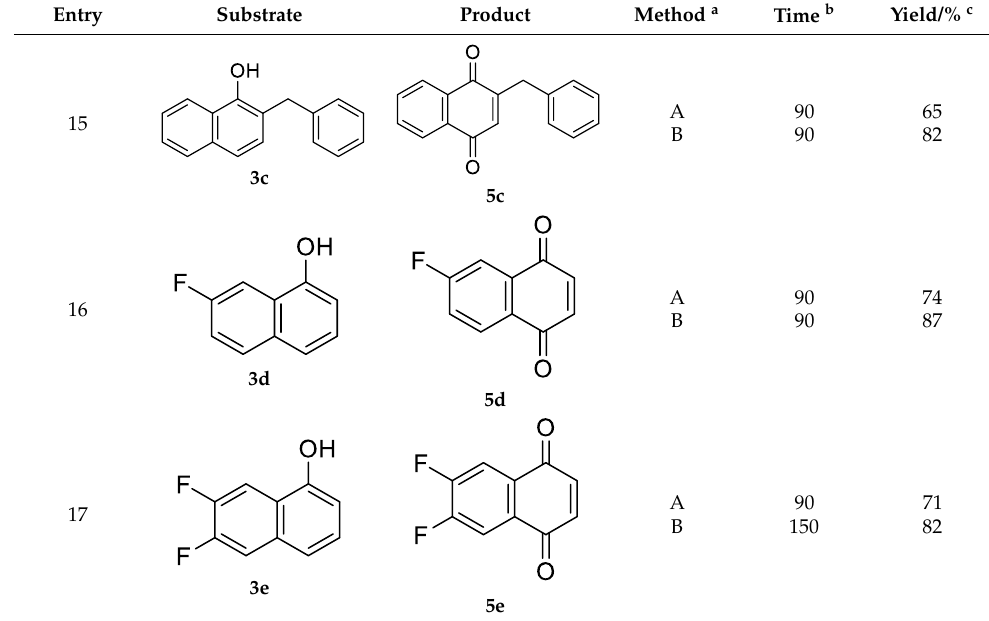
Table 2. In vitro antiparasitic activity, host toxicity and key physicochemical properties of the tested compounds.